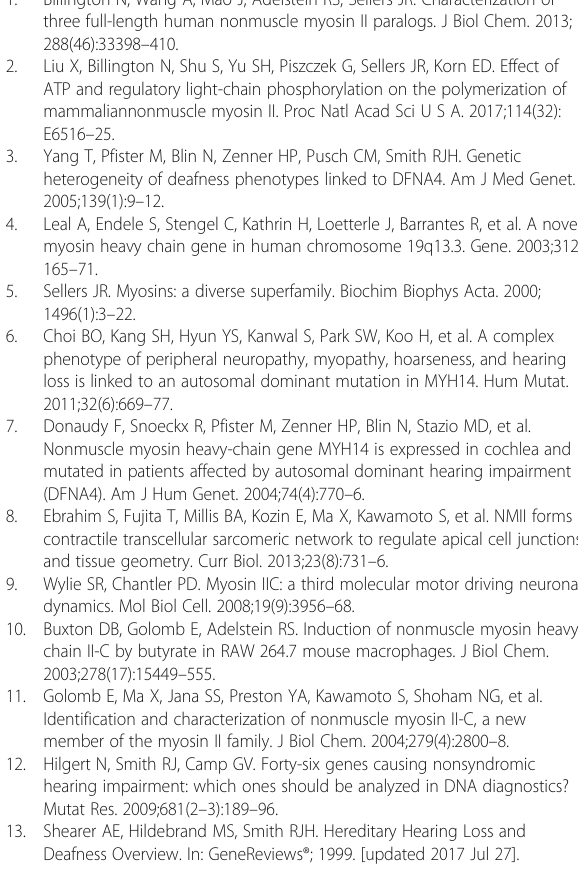
Additional file 1: Table 1. Summary of the 127 targeted deafness genes. Additional file 2: Table 2. Candidate variants were verified in the family using Sanger